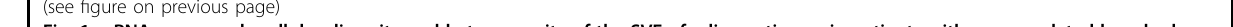
Fig. 1 scRNA-seq reveals cellular diversity and heterogeneity of the SVF of adipose tissues in patients with cancer-related lymphedema. a Schematic representation of the experimental procedure. Patients with cancer-related lymphedema ( n = 5; the CASE group) and healthy donors ( n = 4; the CTRL group) were recruited in this study. Liposuction specimens from the thighs were collected during surgery. scRNA-seq was performed separately for each individual. b Unbiased clustering of 70,209 cells revealed 21 cellular clusters. The number in parentheses represents the cell count. c Hierarchical clustering of the clusters based on the mean expression of the 2000 most variable genes. d Expression of the established marker genes for each lineage in each cluster. e Representative molecular signatures for each cell cluster. The area of the circles indicates the proportion of cells expressing the gene, and the color intensity re fl ects the expression intensity. ASC, adipose-derived stromal/stem/progenitor cell; cDC, conventional dendritic cell; EDO, endothelial cell; MAC, macrophage; NK, natural killer cell; NKT, natural killer T cell; prolif.NKT, proliferative nature killer T cell; pDC, plasmacytoid dendritic